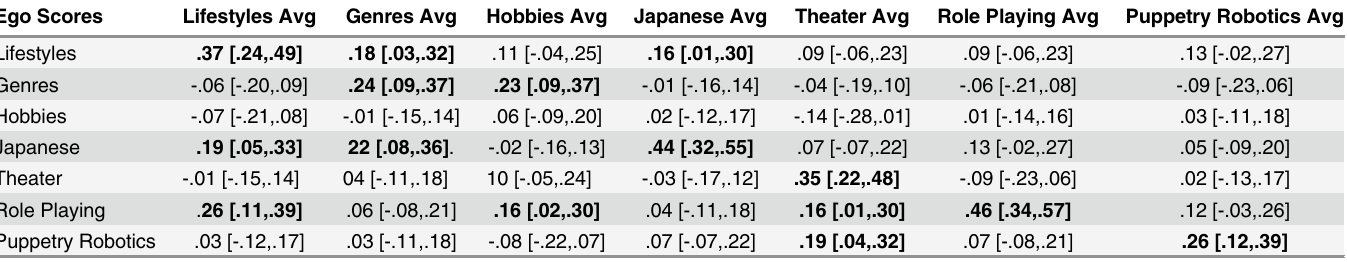
Table 9. Beta Coefficients between Ego Geek Scores and the Average Geek Scores of their Networks Controlling for Correlation Between